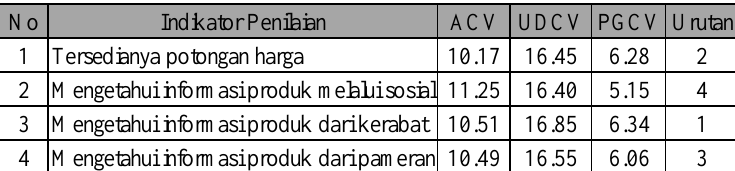
Tabel 3. Nilai indeks PGCV variabel promotion